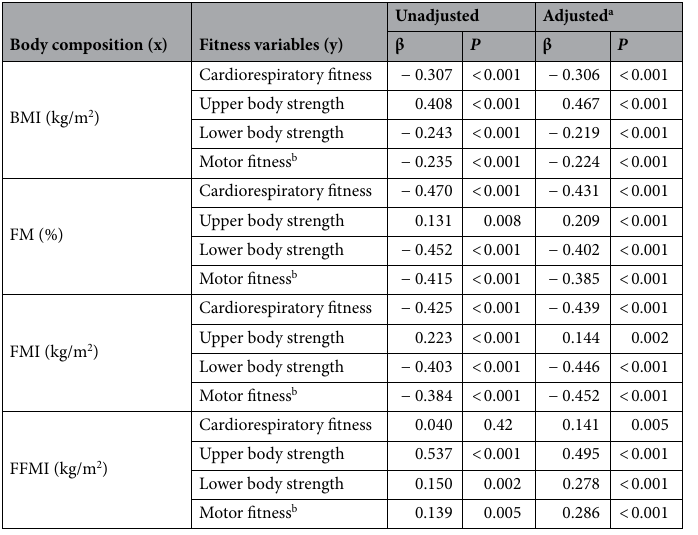
Table 2. Associations of body composition with physical fitness in 9-year-old children. β, standardized regression coefficient; BMI, body mass index; FFMI, fat-free mass index; FM, fat mass; FMI, fat mass index. a Adjusted for child’s age and sex, maternal educational level and maternal BMI (for models with FMI and FFMI as independent variables, the models were also mutually adjusted for FMI and FFMI). b Since lower scores indicate higher performance, results are inverted.